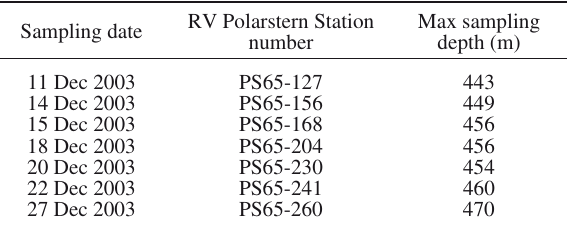
Fig . 1. – (a) Map of the Weddell Sea showing the location of the study area (rectangle). (b) detailed map of the area marked by the red rectangle in (a) showing the location of the quasi-permanent station (dot) on the eastern Weddell Sea Table 1. – Sampling list: dates, corresponding RV Polarstern station number and maximum depth. In the deepest water layers, samples were collected 1.5-2 metres above the bottom.